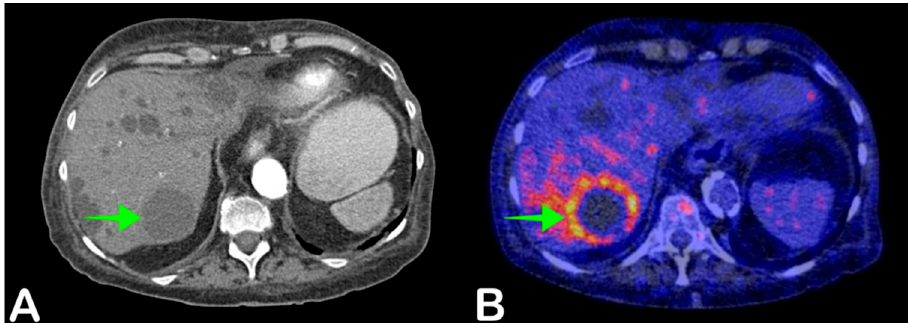
Figure 6. A 68-year-old woman presented with general malaise and night sweats for two weeks. She did not have a fever. She had received a kidney transplant 20 years earlier due to kidney failure caused by autosomal dominant polycystic kidney disease (ADPKD). Blood cultures were positive for Escherichia coli . Abdominal CT showed multiple liver cysts consistent with ADPKD, but no obvious signs of infection ( A , green arrow). Fused axial FDG-PET/CT demonstrated increased FDG uptake in a large cyst in liver segment VII, suggestive of infection ( B , green arrow). Antibiotic therapy was started with ciprofloxacin, after which the patient recovered.